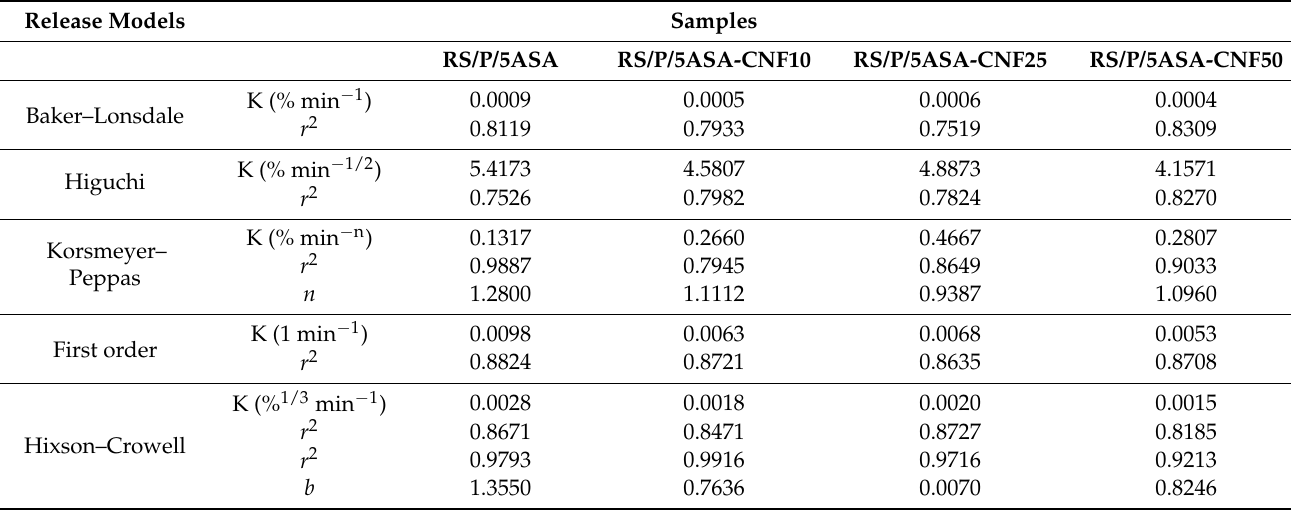
Table 4. Release coefficients of mathematical release models (Baker–Lonsdale, Higuchi, Korsmeyer–Peppas, First order, Hixson–Crowell and Weibull) from spray-dried